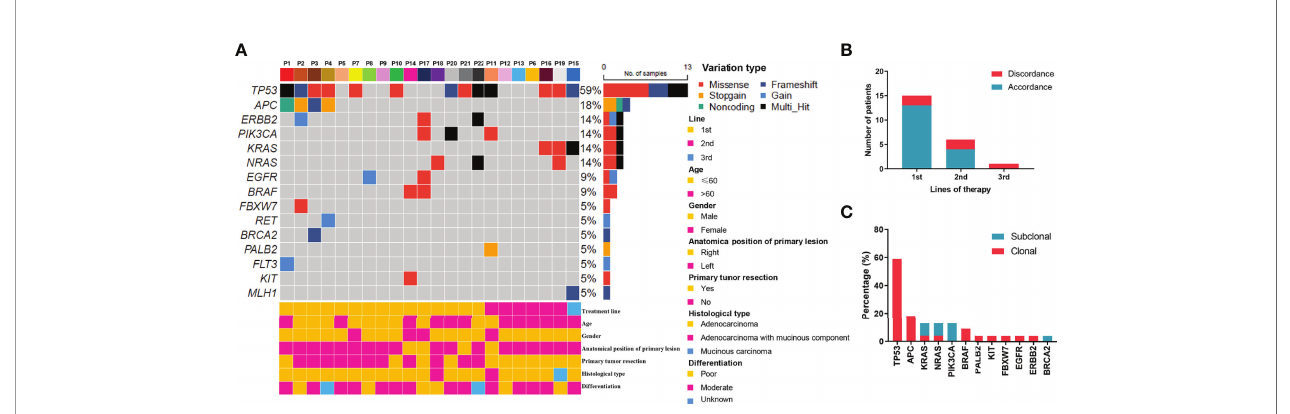
FIGURE 1 | Mutation pro fi ling of pre-treatment ctDNA. (A) Genomic pro fi les of 22 advanced colorectal cancer patients from pre-treatment ctDNA. (B) The consistency of the RAS mutations detected in paired tissues and plasma. (C) The clonal and subclonal landscapes in 22 mCRC patient at baseline. Gain: segments with log ratio more than 3 times of standard deviation of all segment level were considered as “ gain